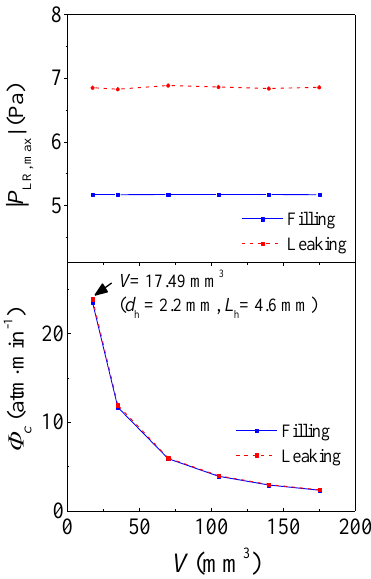
Figure 12. E ff ect of the hohlraum volume on the critical pressure variation rate Φ c and the maximum pressure di ff erence across the hole on the support tent ∆ P LR, max . ( d o = 0.2 mm, N s = 1, d x = 0.1 mm, l x = 500 mm).